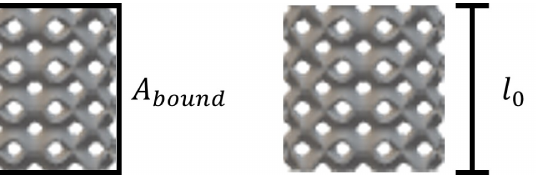
Figure 3. Depiction of the bounding cross-sectional area and original height of a lattice